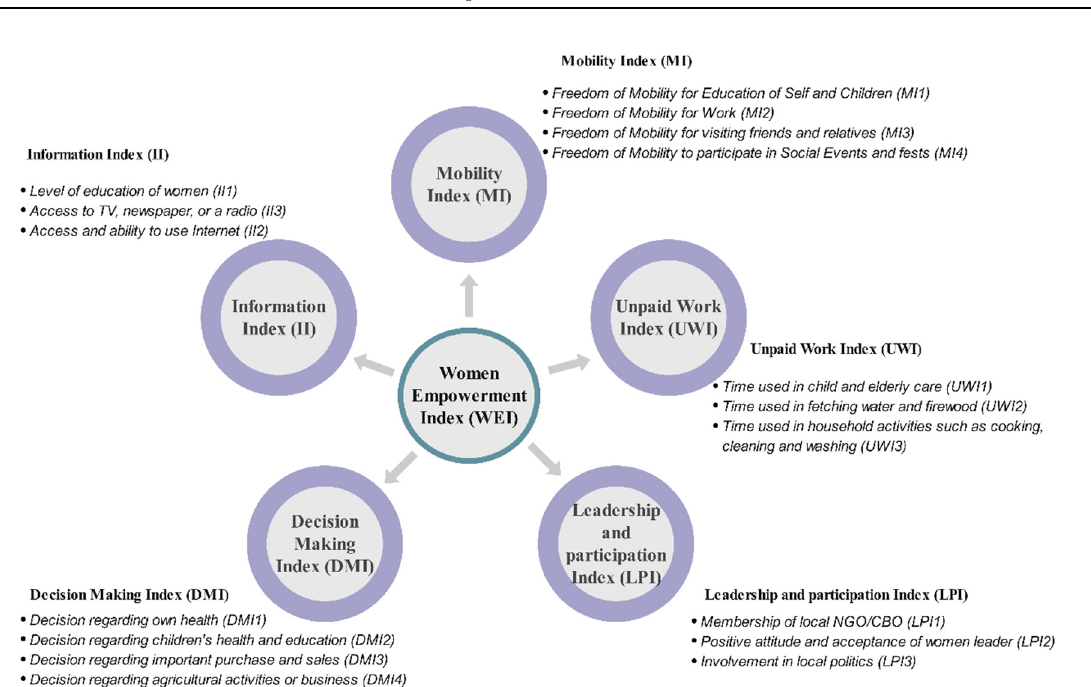
Figure 3. Components and Indicators of the Women Empowerment Index (WEI) used in this study. Table 1. WEI components, indicators, indicators’ relation to empowerment, and criteria for selection of indicators. RSC and EJ refer to Relevance to Study Context and Experts’ Judgement, respectively.